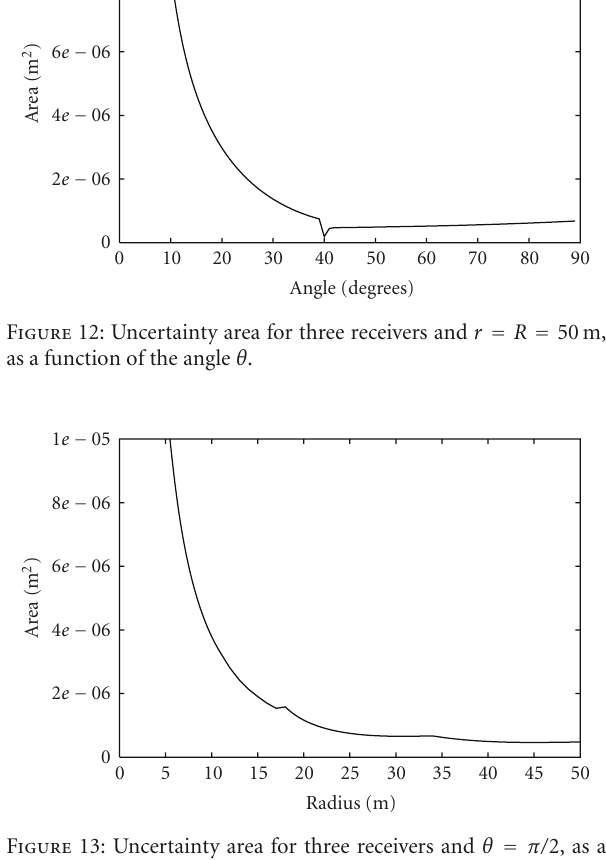
Figure 13: Uncertainty area for three receivers and θ = π/ 2, as a function of the radius r